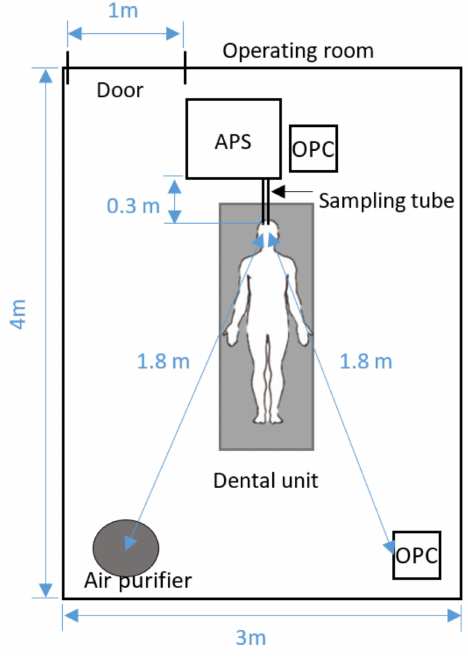
Figure 1. Schematic of the experimental setup.